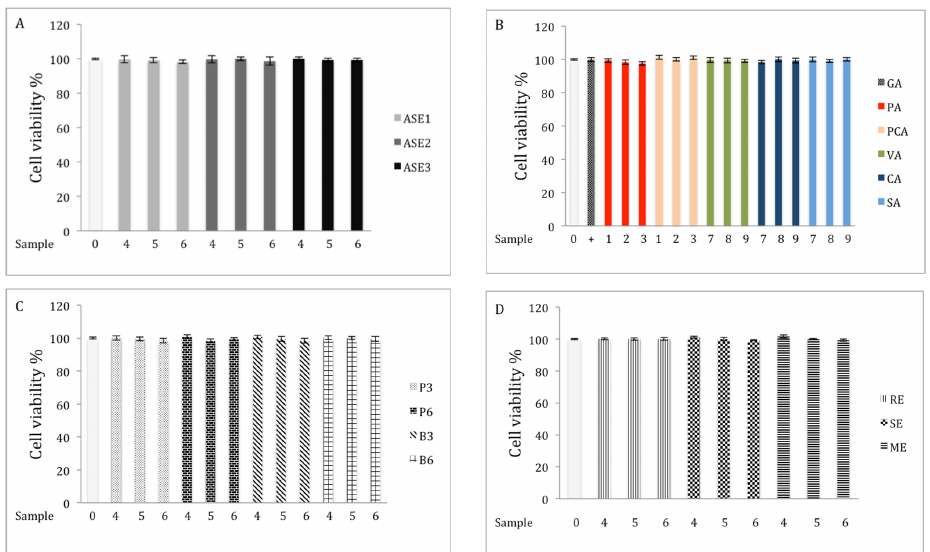
Figure 1. Effects of different extracts and phenolics on cell viability of RAW264.7 cells. Extracts were obtained by ( A ) ASE conditions, ( B ) pure phenolic acid standards, ( C ) crude polysaccharide extracts, and ( D ) different extraction methods. Cells were stimulated with 1 μ g/mL of LPS plus varying concentrations of samples (0 = media, GA = 2 μ M; 1 = 5 μ M; 2 = 10 μ M; 3 = 20 μ M; 4 = 50 μ g/mL; 5 = 100 μ g/mL; 6 = 150 μ g/mL; 7= 25 μ M; 8 = 50 μ M; and 9 = 100 μ M).